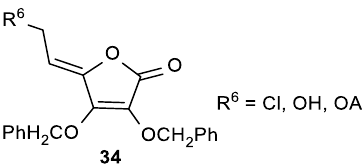
l -ascorbic acid Figure 14. The 6-chloro-2,3-di- O -benzyl- L -ascorbic acid derivative. Figure 14. The 6-chloro-2,3-di- O -benzyl- Figure 14. The 6-chloro-2,3-di- O -benzyl- L -ascorbic acid derivative.